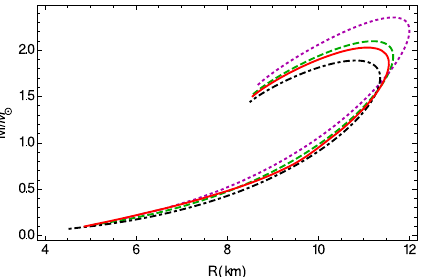
Fig. 17 Variation of the total mass M / M (cid:2) as a function of the radius of the star R for three-form field quark stars, for three different values of the constant ¯ λ : ¯ λ = 0 (dashed curve), ¯ λ = 0 . 02 (dotted curve), and ¯ λ = − 0 . 02 (dot-dashed curve), respectively. The solid curve represents